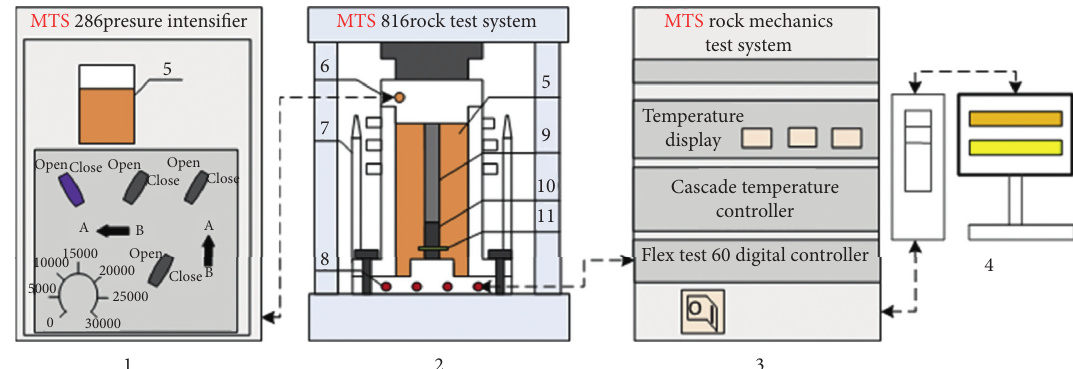
Figure 2: MTS816 test system. (1) Hydraulic control system. (2) Triaxial experimental platform. (3) Control cabinet. (4) Data acquisition system. (5) Hydraulic oil. (6) Confining pressure cavity. (7) Positioning rod. (8) Sensor interface. (9) Loading device. (10) Specimen. (11) Ring extensometer.